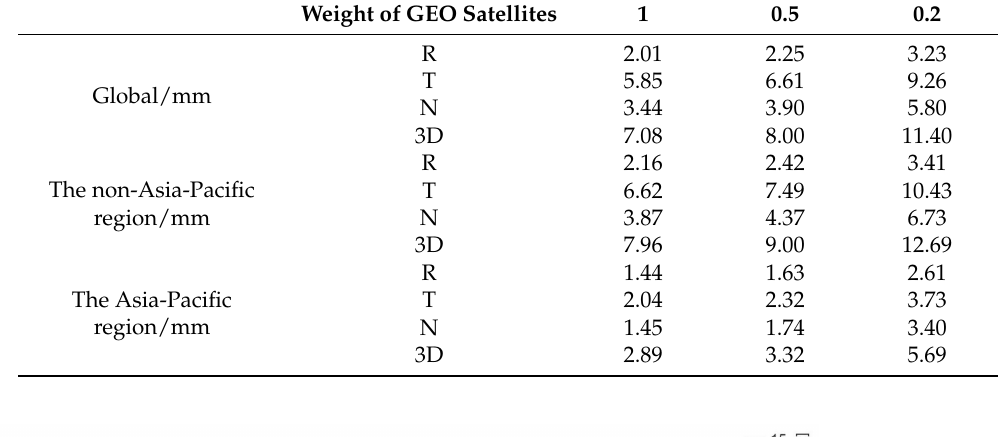
Table 3. Difference between the GPS-based and BDS2-based PROD with different weights of GEOs (excluding maneuver periods).